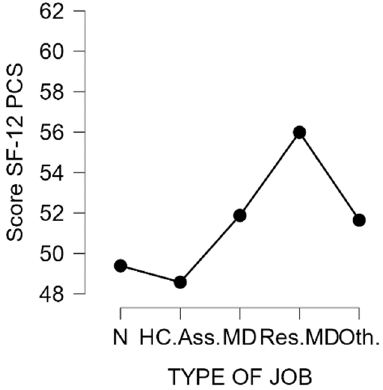
Figure 2. PCS score according to the type of job. N = Nurse; HC.Ass. = Healthcare Assistants; MD = Physicians; Res.MD = Resident Physicians; Oth = Others.